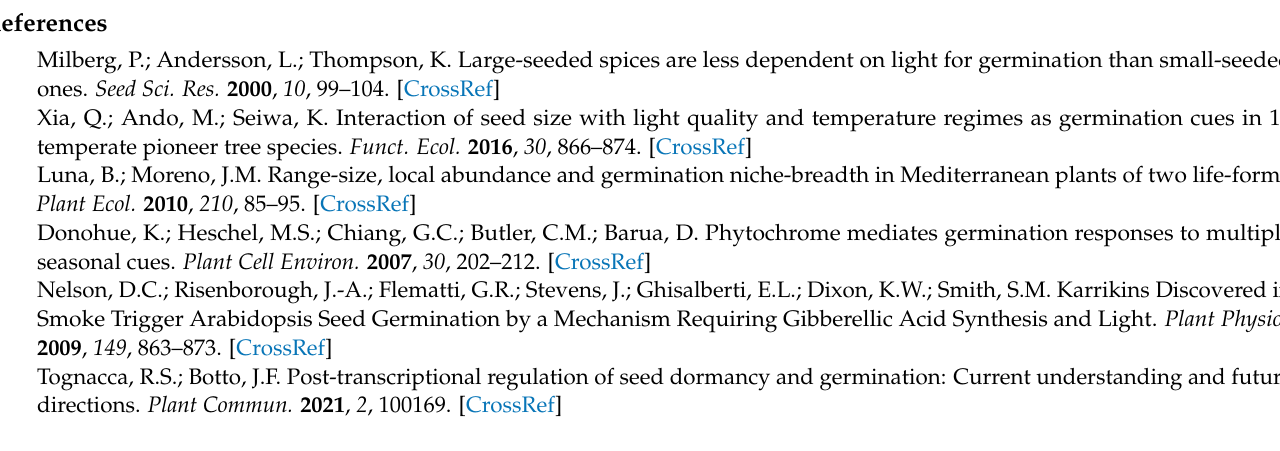
Figure 2. The impact on KAR on phytohormonal balance determining seed dormancy and germination.